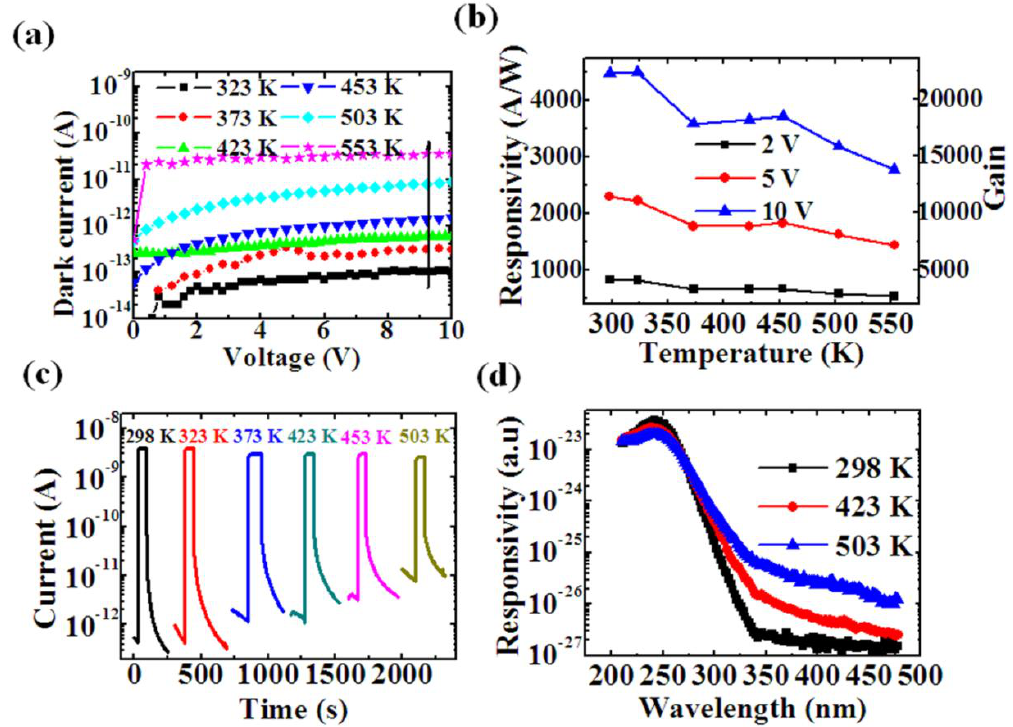
Figure 21. Photoresponse properties of the β -Ga2O3 nanowire based photodetectors at various elevated temperatures. ( a ) Dark current-voltage characteristics at various temperatures. ( b ) Responsivity at the 250 nm light illumination dependence on the temperature. ( c ) Time response upon the 250 nm light illumination at various temperatures at 5 V. ( d ) Spectral response measured at 5 V at different